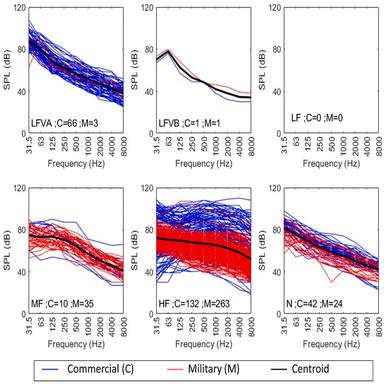
Spectrum classification in 6 groups using the RCmarkII noise rating. LFVA (Low-frequency range dominant (16–63 Hz) and vibration A), LFVB (Lowfrequency range dominant (16–63 Hz) and vibration B), LF (Low-frequency range dominant (16–63 Hz), MF Mid-frequency range dominant (125–500 Hz)) HF Highfrequency range dominant (1000–4000 Hz) and N Balanced sound spectrum, no single frequency range dominant.